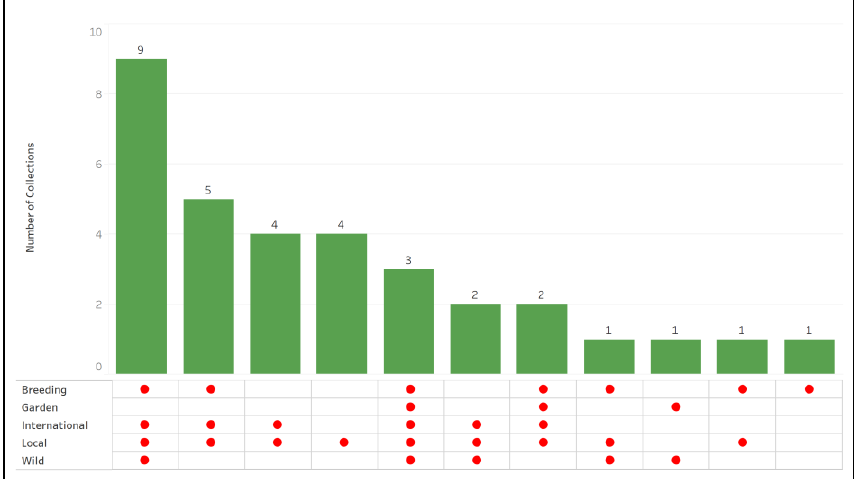
Figure 2. The conservation priorities of collections that hold various types of citrus plant genetic resources accessions.